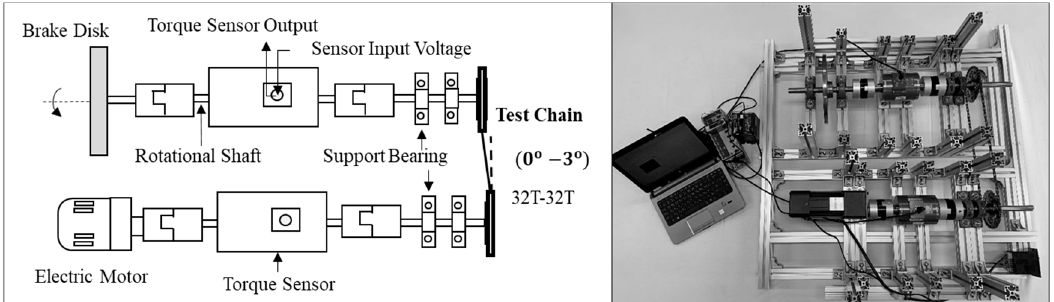
Figure 8. Schematic of setup and test stand equipment.